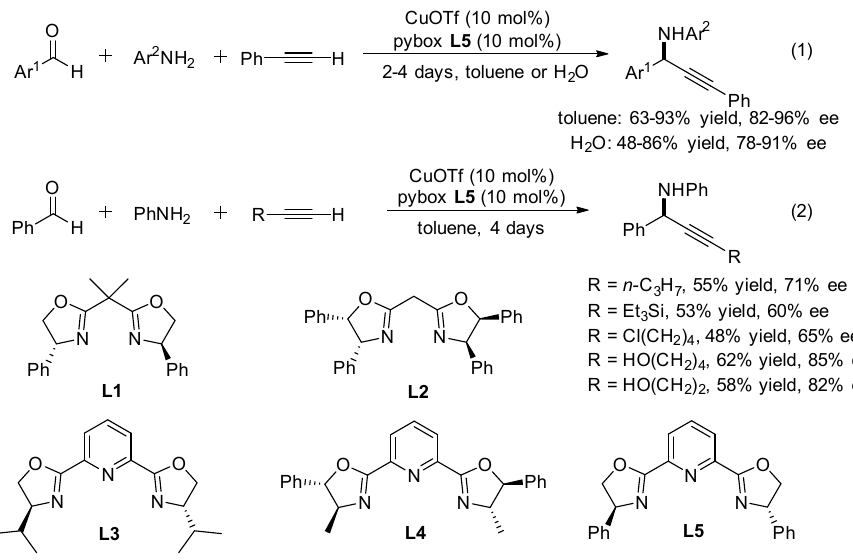
Figure 3. Enantioselective three-component reaction with box and pybox ligands.